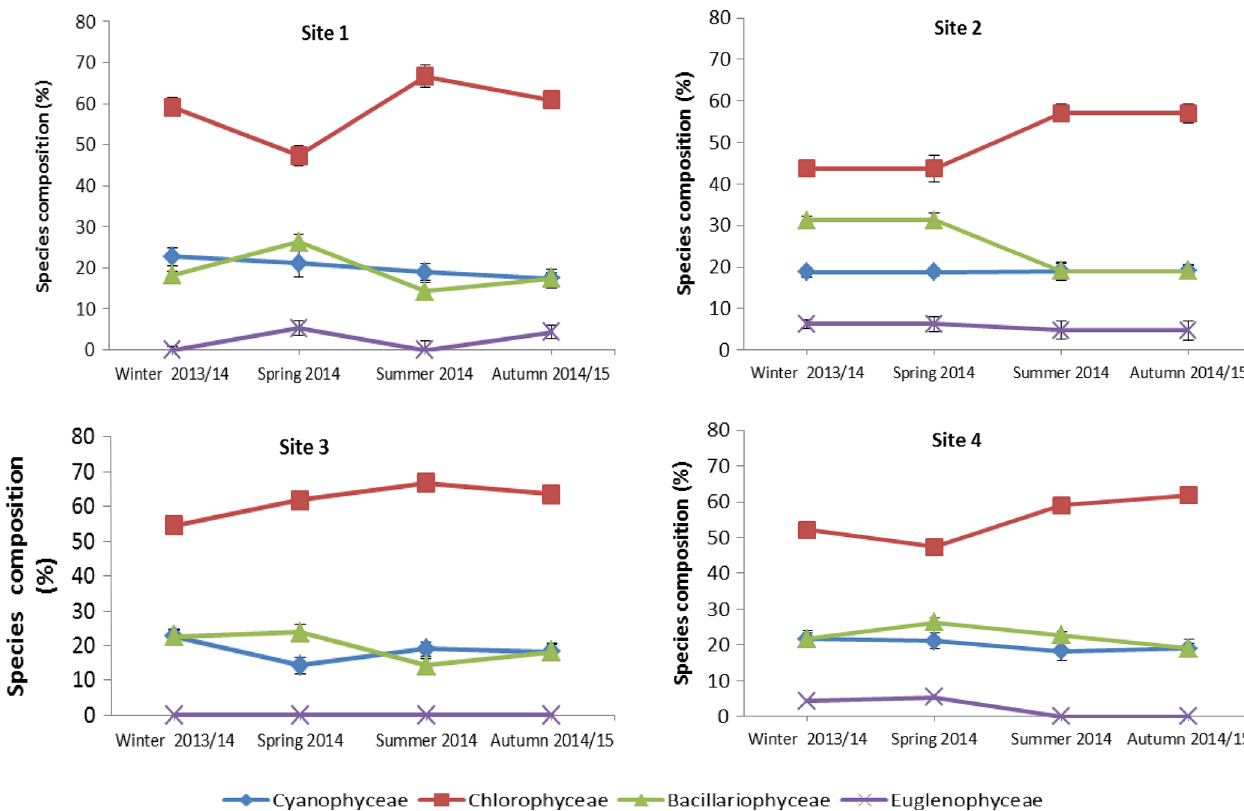
Fig. 3. Seasonal phytoplankton composition in Lake Chamo